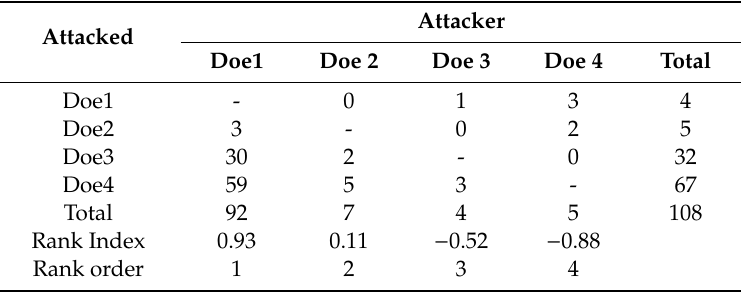
Table 3. Dominance rank order based on the number of fights among the does (HET1).